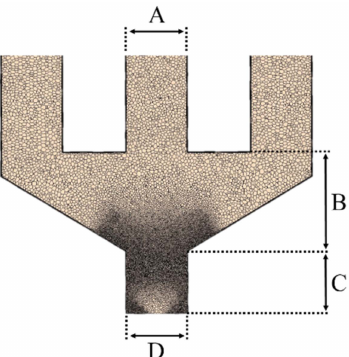
Figure 3. Two-dimensional section of the polyhedral mesh, corresponding to atomizer geometry in Figure 1. ( A ) Diameter of the gas capillary; ( B ) length of the mixing zone; ( C ) length of the exit orifice; ( D ) diameter of the exit